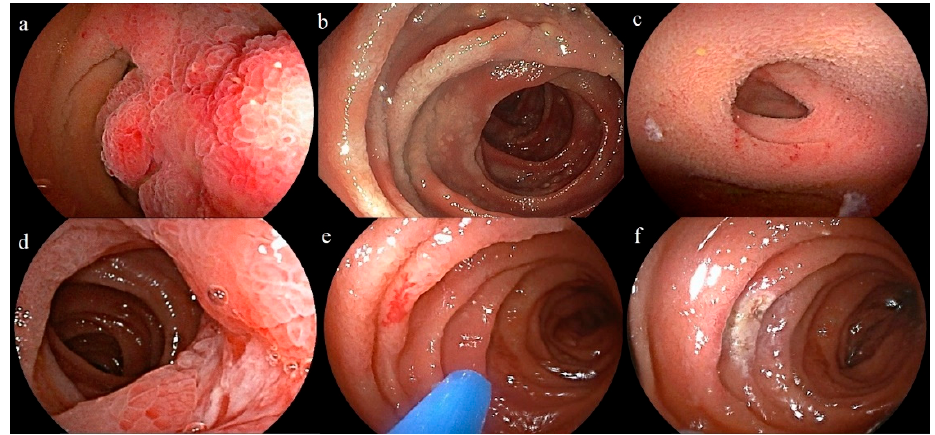
Figure 1. Examples of pathological findings. ( a ) Jejunal hamartoma. ( b ) Jejunal lymphoma. ( c ) Meckel’s diverticulum. ( d ) Jejunal Crohn’s disease. ( e ) Jejunal angioectasia ( f ) Jejunal angioectasia after treatment with argon plasma coagulation.